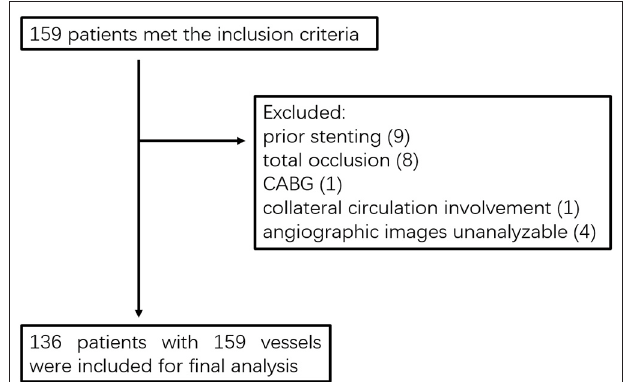
FIGURE 1 | Study flowchart. CABG, coronary artery bypass grafting.